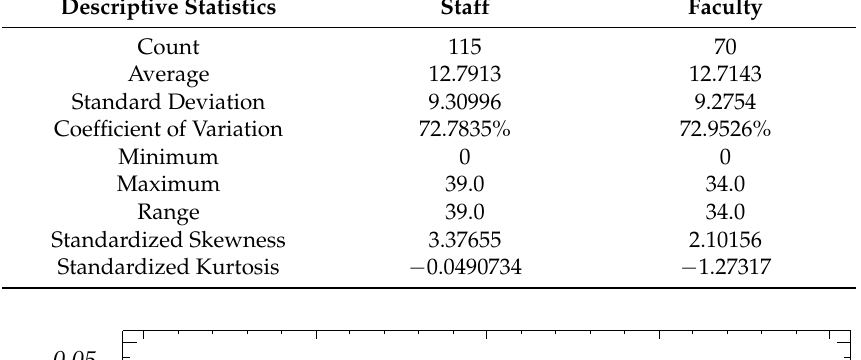
Table 4. Statistical summary of BDI-II scores by group (staff and faculty).